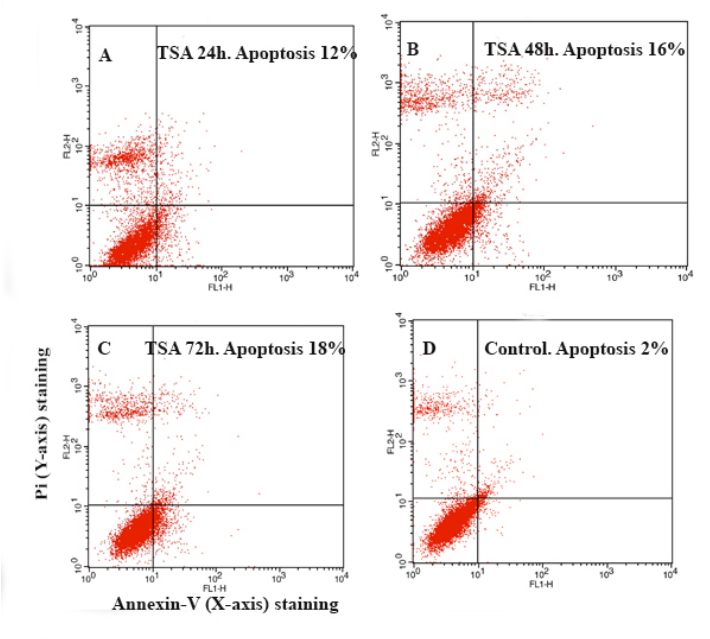
FIGURE 2 – The apoptotic effects of TSA with a concentration of 5 μM. The compound induced significant apoptosis in WCH 17 cells at different time periods (24, 48 and 72 h). In the panels, the lower left quadrant shows viable cells, which exclude PI and are negative for FITC-Annexin V binding (annexin V–negative/PI-negative). Apoptotic cells staining with annexin V-FITC, but not PI (annexin V–positive/PI-negative), appear in the lower right (LR) quadrant of data plots. Late apoptotic/necrotic cells appear in the upper right (UR) quadrant, staining with both PI and annexin V-FITC, cells positive for FITC-Annexin V binding and for PI uptake and finally necrotic cells are precented in the left upper quadrant (annexin